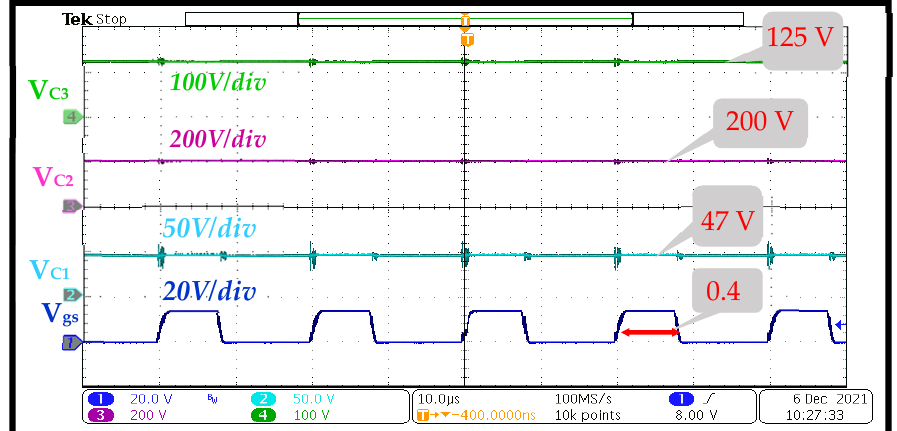
Figure 22. The experimental waveform of ( 1 ) Duty cycle (V gs ) at d = 0.4, ( 2 ) Capacitor (C 1 ) voltage (V C1 ), ( 3 ) Capacitor (C 2 ) Voltage (V C2 ), and ( 4 ) Capacitor (C 3 ) Voltage (V C3 ).